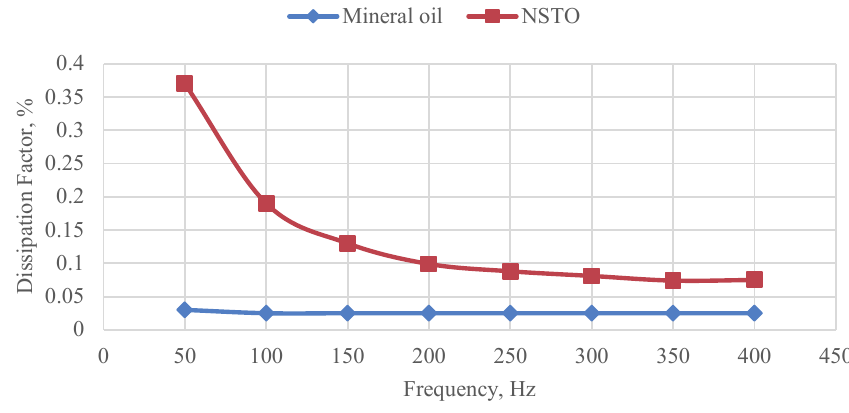
Fig. 2. Dissipation factor changes in relation to frequency.